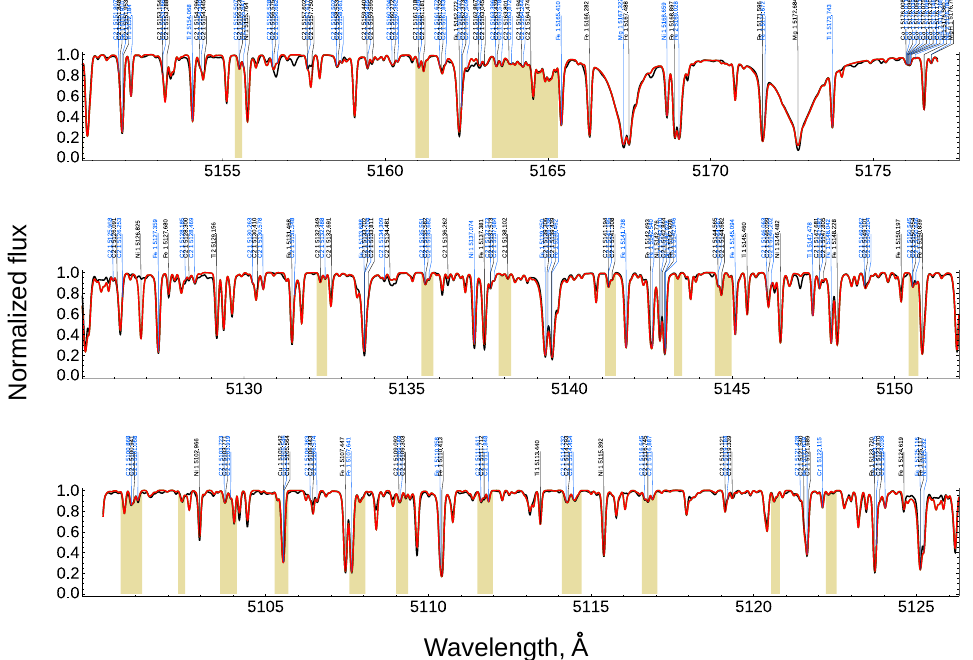
Figure 2. Spectral mask in the 5100–5200 Å region of the solar atlas. Observations are shown by the black line. The color bands highlight selected intervals. The SME fitting results are shown by the red line. Only 10% of the strongest transitions are marked on the